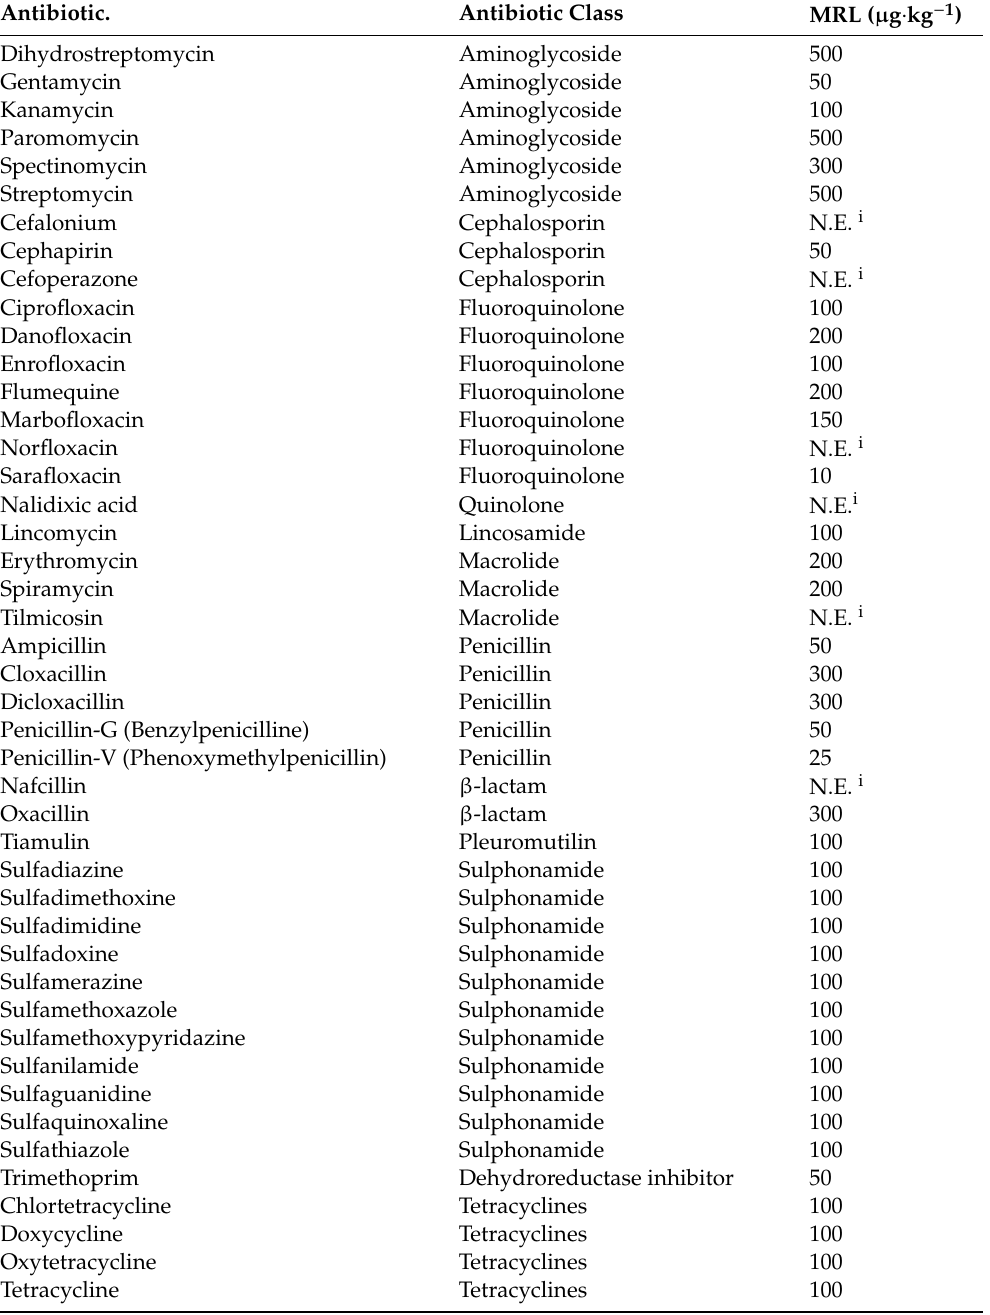
Table 1. Veterinary antibiotics and maximum residue limits (MRLs) in porcine muscle.